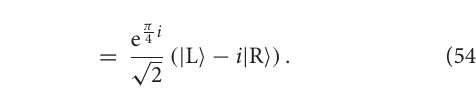
E x ) and (B) the phase ( φ x ) of the | |